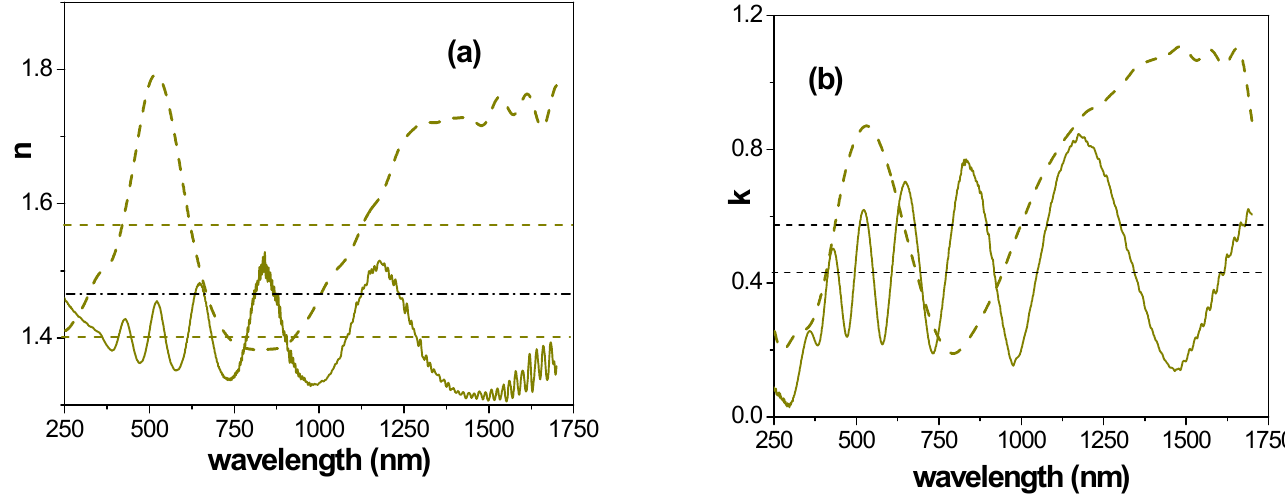
Figure 5. Comparison of wavelength dependence for the refraction index ( a ) and the extinction coefficient ( b ) at a light incident angle of 65 ◦ . Solid lines: Ox(A)/SiO 2 sample; dashed lines: Ox(b)/SiO 2 sample. Dark yellow horizontal lines indicate the average (<n> and <k>) values for each sample; a black horizontal dashed-dot line indicates the tabulated value of SiO 2 refractive index (at λ = 632.8 nm).